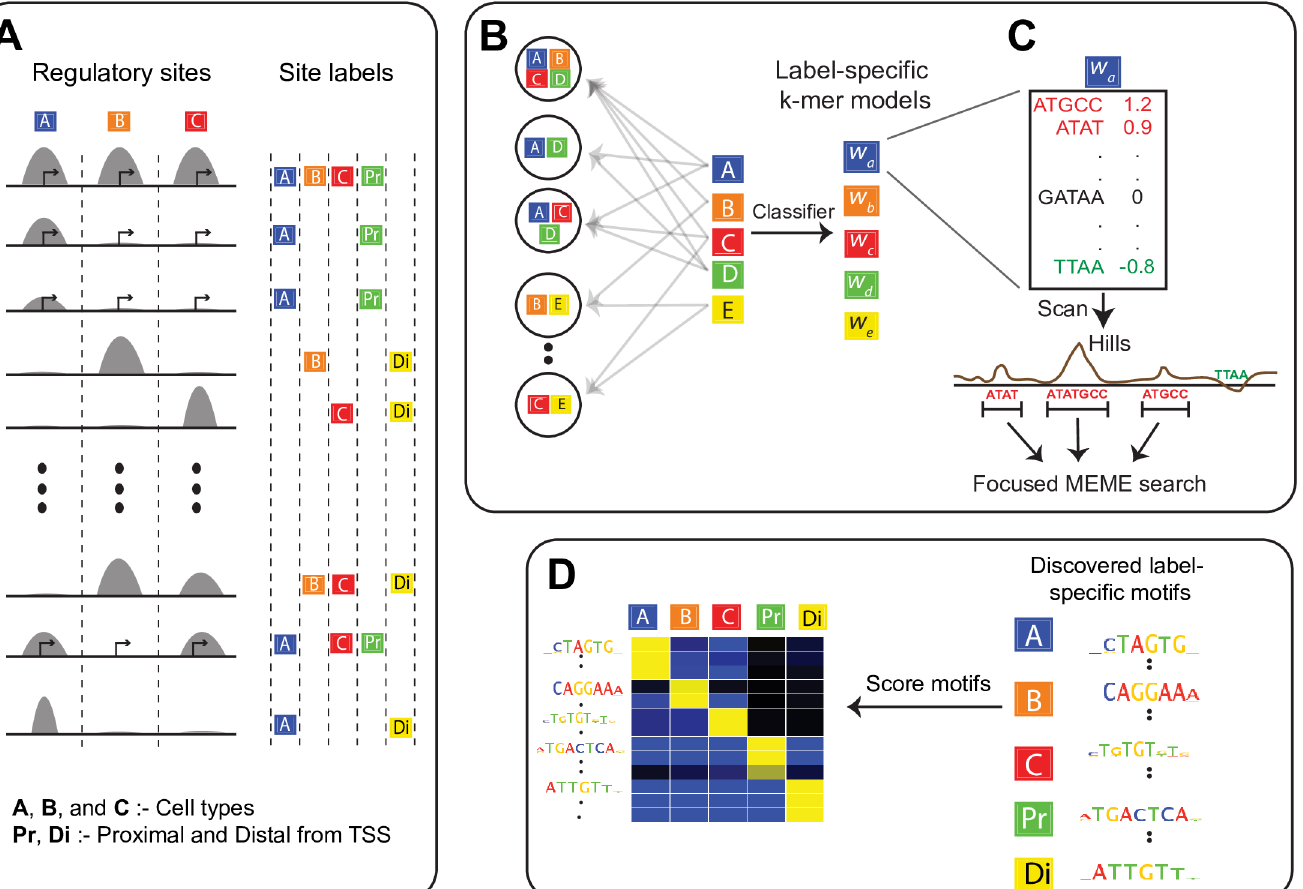
Fig 1. Overview of SeqUnwinder, which takes an input list of annotated genomic sites and identifies label-specific discriminative motifs. (A) Schematic showinga typical input instancefor SeqUnwinder: a list of genomiccoordinates and corresponding annotationlabels. (B) The underlying classification framework implemented in SeqUnwinder. Subclasses (combination of annotation labels) are treated as different classes in a multi-class classification framework. The label-specificpropertiesare implicitlymodeledusing L1-regularization. (C) Weighted k -mer models are used to identify 10- 15bp focus regions calledhills. MEME is used to identify motifs at hills. (D) De novo identifiedmotifs in C) are scored using the weighted k -mer model to obtain label-specific scores.